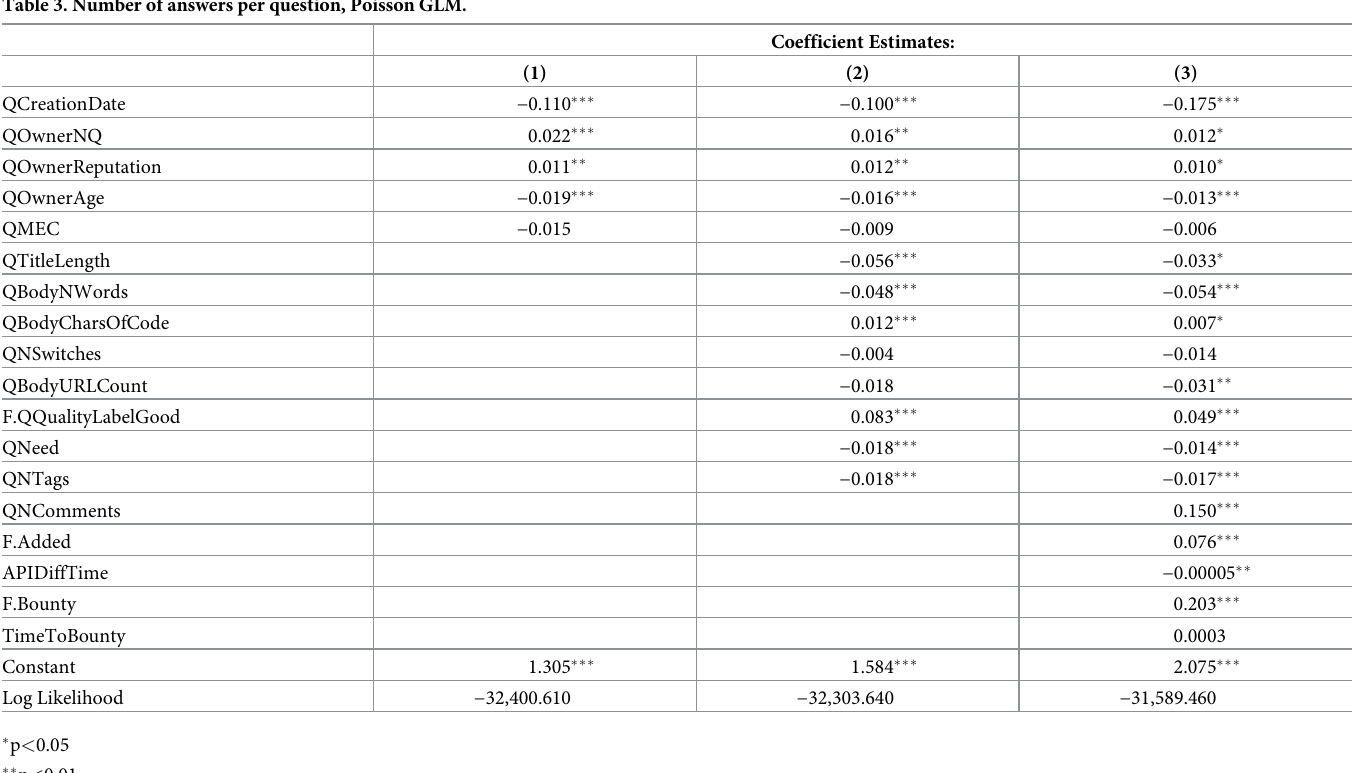
Table 3. Number of answers per question, Poisson